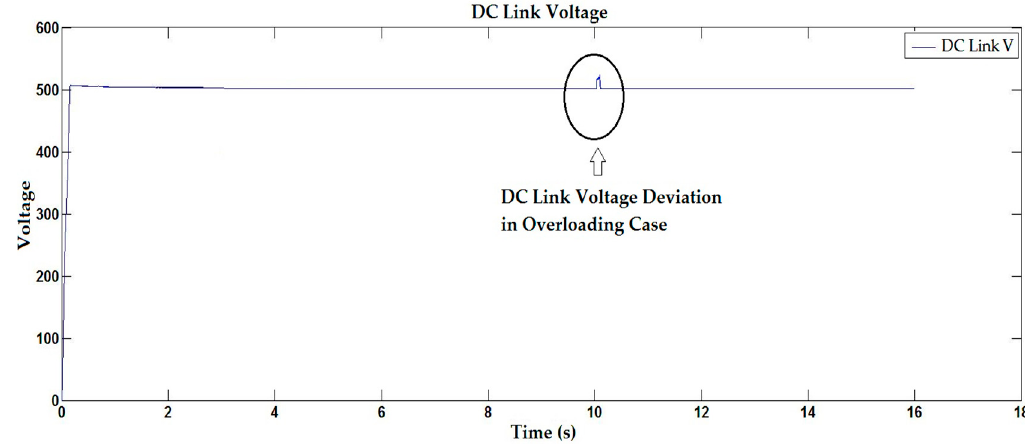
Figure 19 . DC link voltage response in system overloading mode.